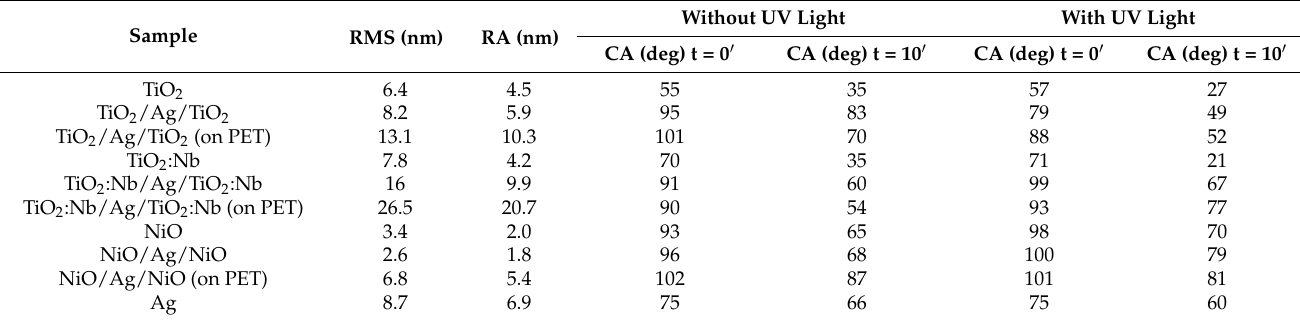
Figure 2. ( a ). SEM image of the Ag interlayer and ( b ) AFM image of the Ag interlayer. Table 2. A summary of RMS and RA roughness values, and contact angle (CA) values of the single oxide layers and the top oxide layers of the multilayer structures (O/M/O) deposited on glass and PET substrates. Sample